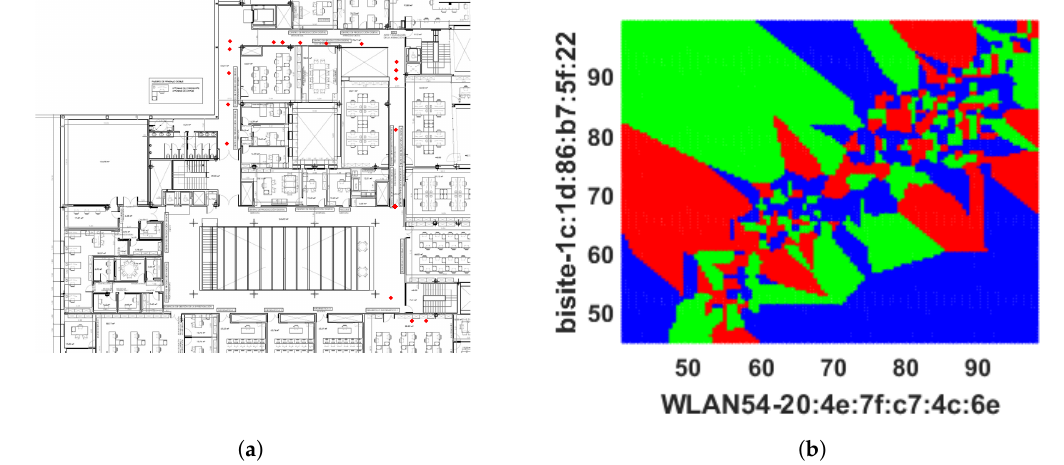
Figure 8. Predicted Paths by SVM: ( a ) the route predicted by SVM RBF classifier; and ( b ) 2D decision boundary formed by SVM RBF